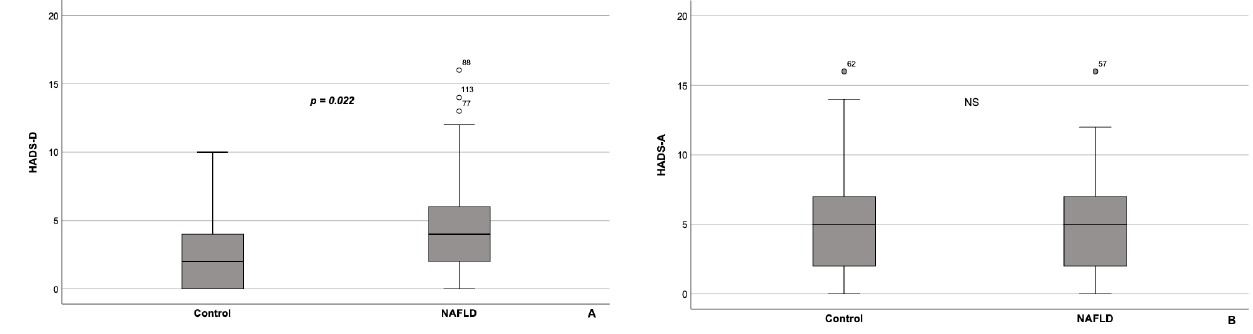
Figure 2. Box Plot of the HADS-D ( A ) and HADS-A ( B ) score values for patients with NAFLD ( n = 95) and controls ( n = 37). Patients with NAFLD had significantly higher HADS-D scores, compared with the controls ( A ), whereas HADS-A scores did not differ substantially between the groups ( B ). The line through the middle of each box represents the median. The length of the box thus represents the interquartile range. The error bars show the minimum and maximum values of HADS-D and HADS-A scores. Outliers are depicted as circles. HADS-A — Hospital Anxiety and Depression Scale, subscale for anxiety; HADS-D — Hospital Anxiety and Depression Scale, subscale for depression. All comparisons are performed using Mann-Whitney U test. NS — non-significant.